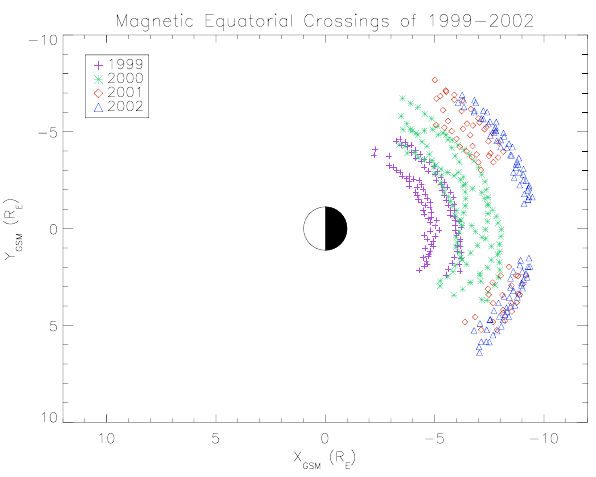
Fig. 5. The locations of the 384 magnetic equatorial crossings that were used for the statistical survey. They are from the months of August, September and October 1999 through 2002. The resulting bar chart in Fig. 6 indicates the